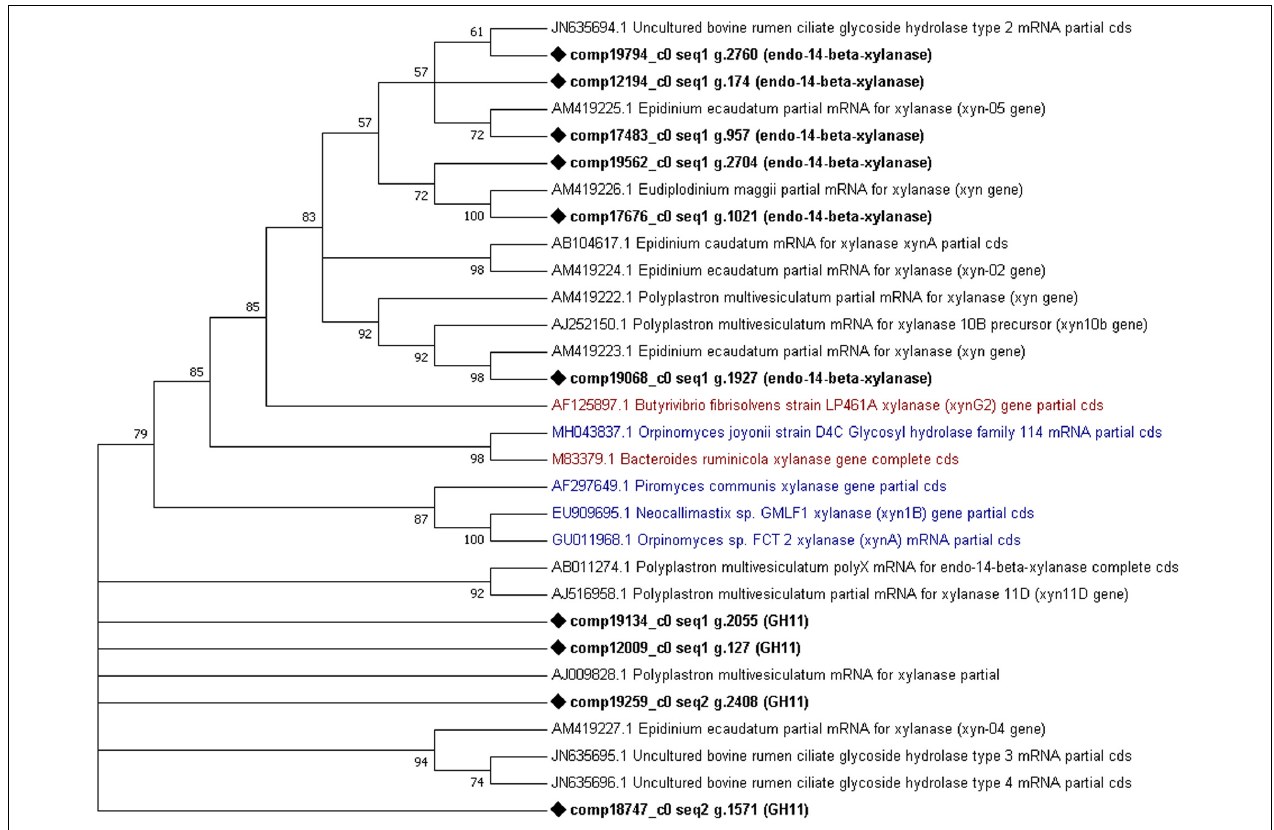
FIGURE 6 | Comparative phylogenetic tree of all putative xylanase (GH10 or GH11) genes detected within the protozoal metatranscriptome. Fourteen representative protozoal sequences from Epidinium ecaudatum (4) , Polyplastron multivesiculatum (5), uncultured bovine rumen ciliates (3) Epidinium caudatum (1) and Eudiplodinium maggii (1), three fungal cellulases produced by Neocallimastix sp. , Piromyces sp., Orpinomyces sp. and Orpinomyces joyonii and two bacterial cellulases from Bacteroides ruminicola and Butyrivibrio fibrisolvens are given for comparison. Target sequences from the metatranscriptome are shown in bold with a diamond shape node marker, the most highly expressed enzyme is marked with a square, protozoal sequences are